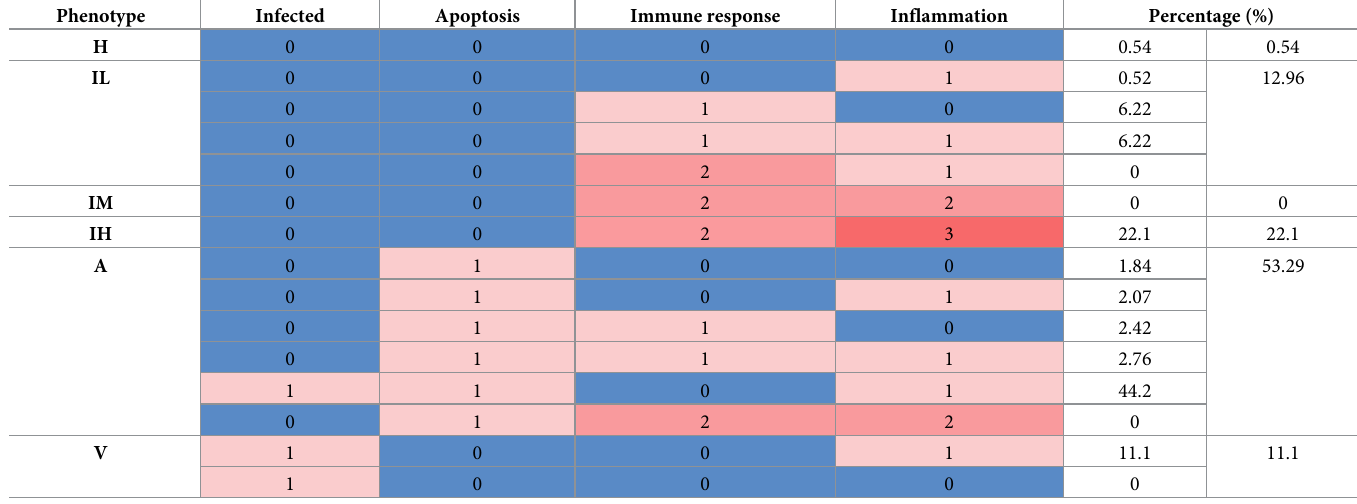
Table 1. Model phenotype repertoire with their relative abundance. The stable states have been grouped in six phenotypes: Viral (V), Apoptotic (A), Inflammatory Low or Medium or High (IL, IM, IH), Healthy (H). The states with null probability cannot be reached in untreated condition but will appear during treatments.